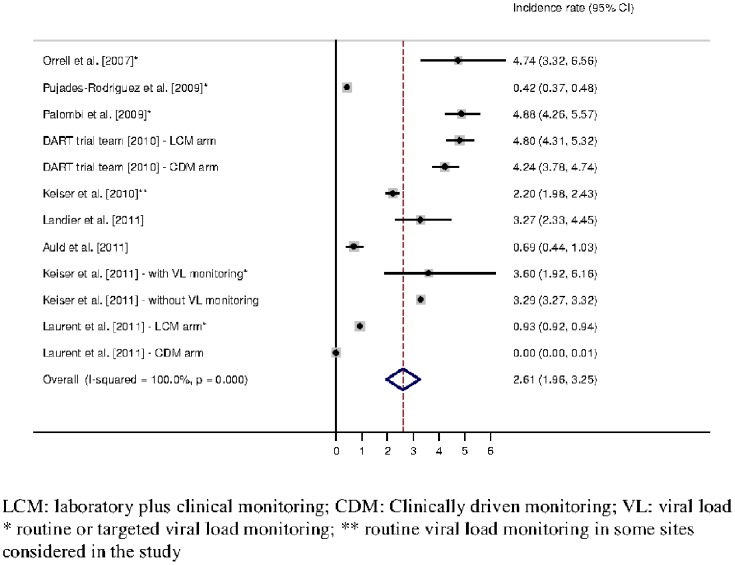
Incidence rate of switching to second-line ART (expressed per 100 person-years) – Estimation from 9 studies providing 11 incidences of switching to second-line ART.